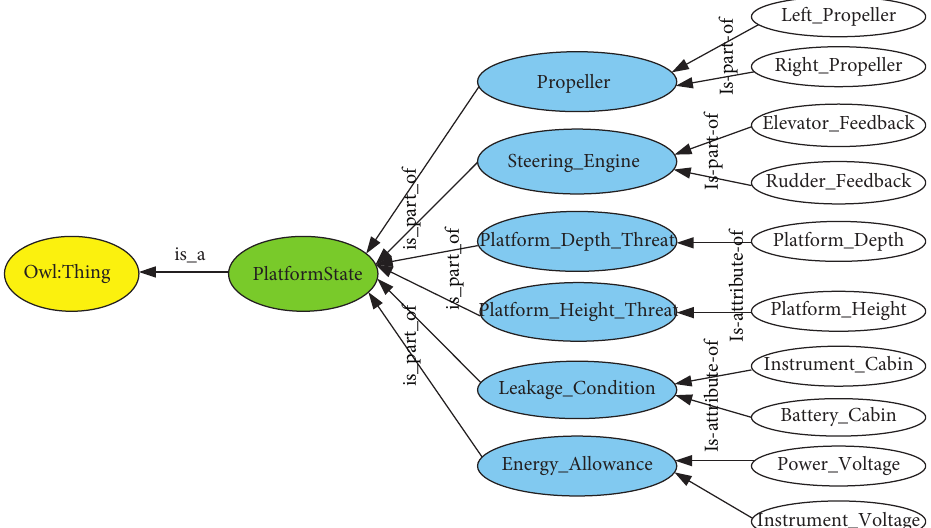
Figure 3: Structure of the UUV platform status application